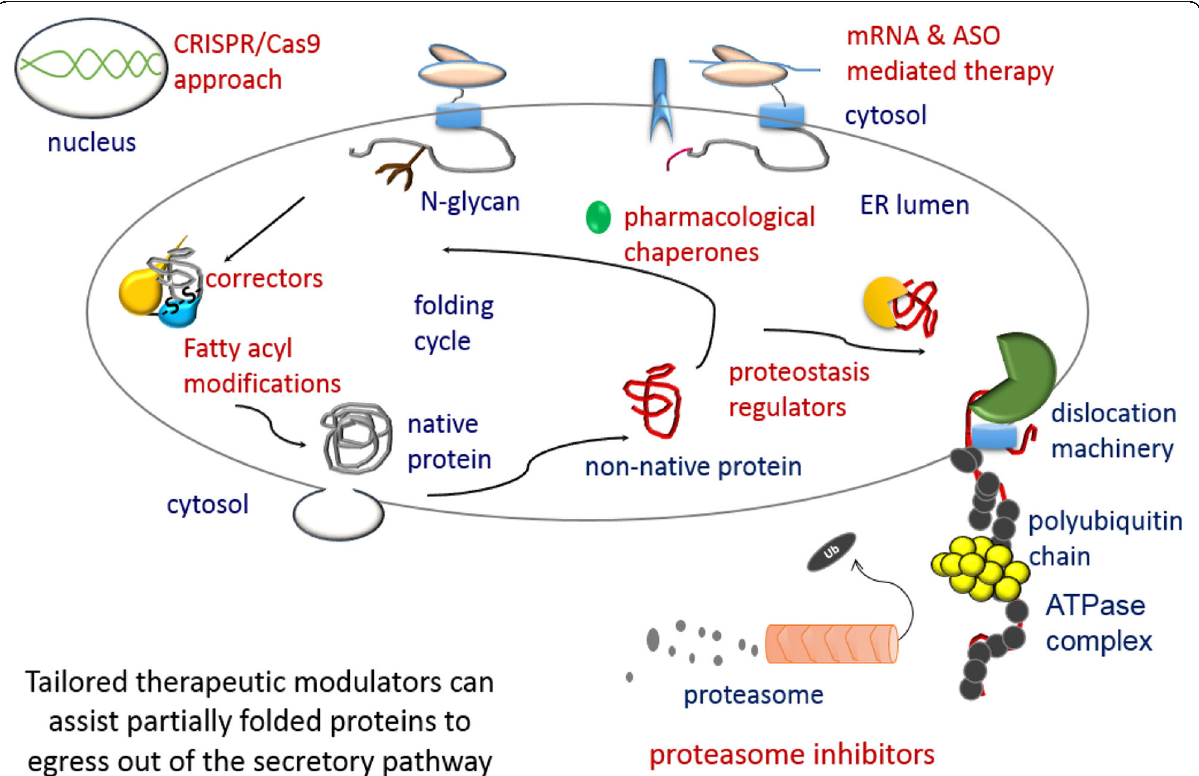
Fig. 6 Summary: Therapeutically targeting the intracellular environment. The endoplasmic reticulum is a very important organelle for the proper folding of proteins that enter the secretory pathway. It contains stringent quality control checkpoints that monitor the folding of polypeptides and allow bone fide proteins to exit the ER and be expressed at their proper cellular localization. Research shows that proteins that are kinetically stable and thermostable in the ER, but do not conform to a proper conformation, can still progress to the secretory pathway and function similar to wild-type protein on the plasma membrane. Select therapeutic strategies are shown in red font. Pharmacological chaperones (correctors) can work at different levels of the folding cycle. Proteostasis regulators works with the ER quality control network and eliminate toxic non-native polypeptides. Fatty acyl modifications assist in proper cysteine bond formation and compact polypeptide folding. Abbreviations; ASO: antisense oligonucleotides, CRISPR/Cas9: clustered regulatory interspaced short palindromic repeats)/cas9